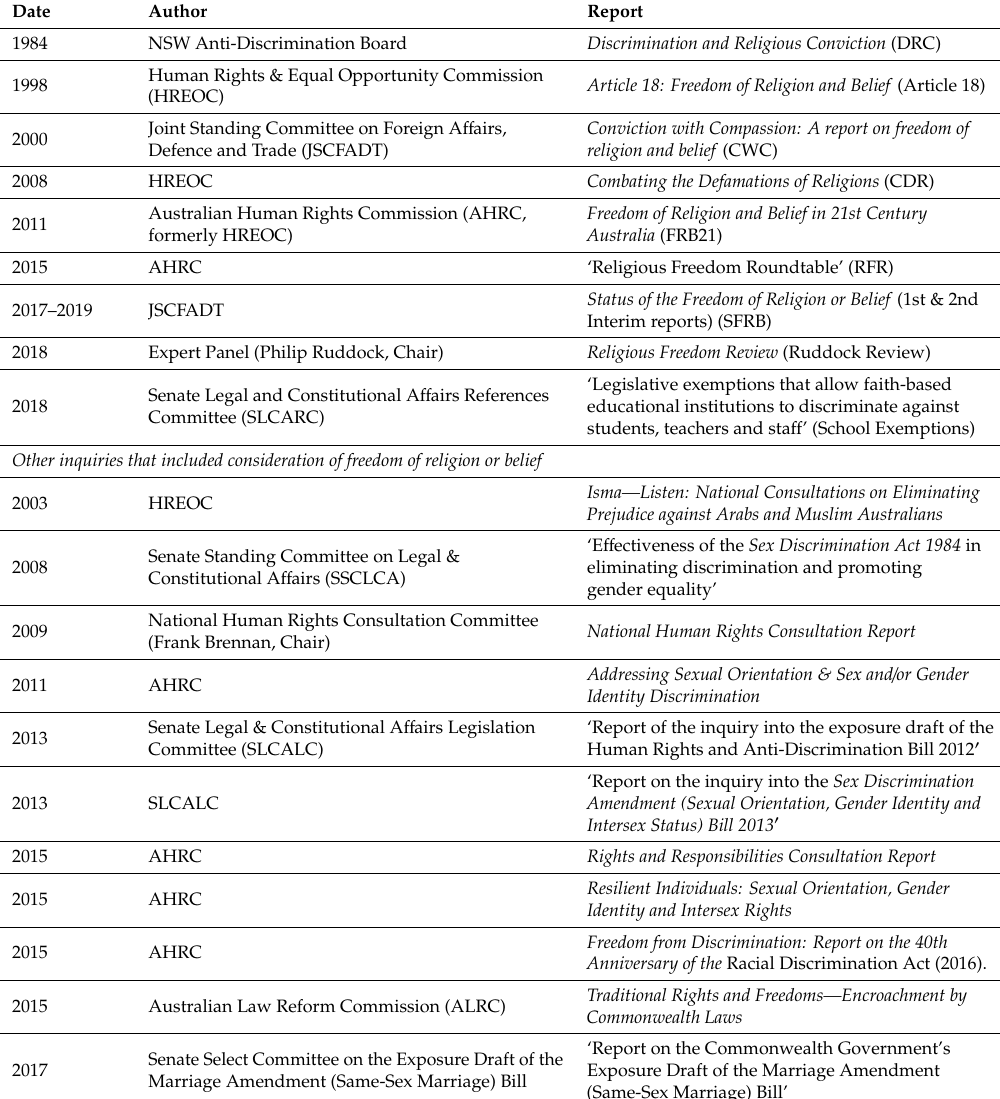
Table 1. The Religious Freedom Inquiry